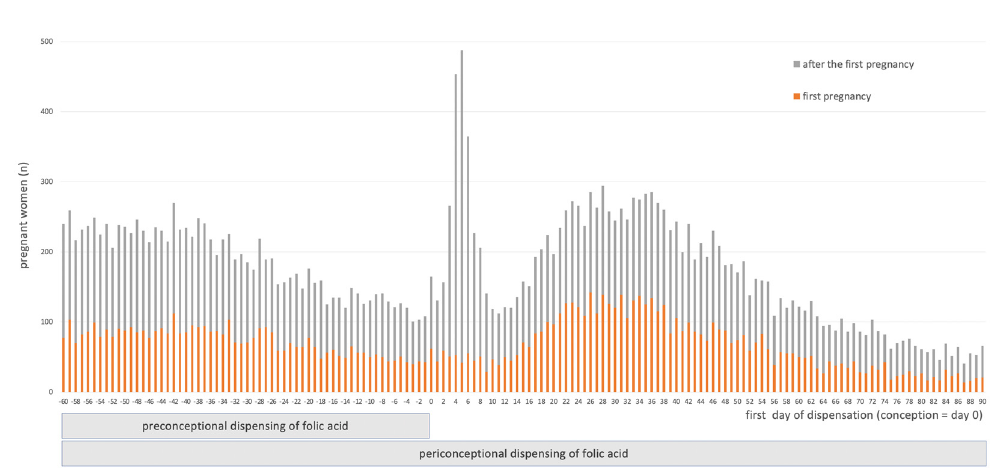
Figure 2. First day of dispensing of folic acid during the periconceptional period among 26,601 pregnancies in which a prescription enabled respect of French and international recommendations.